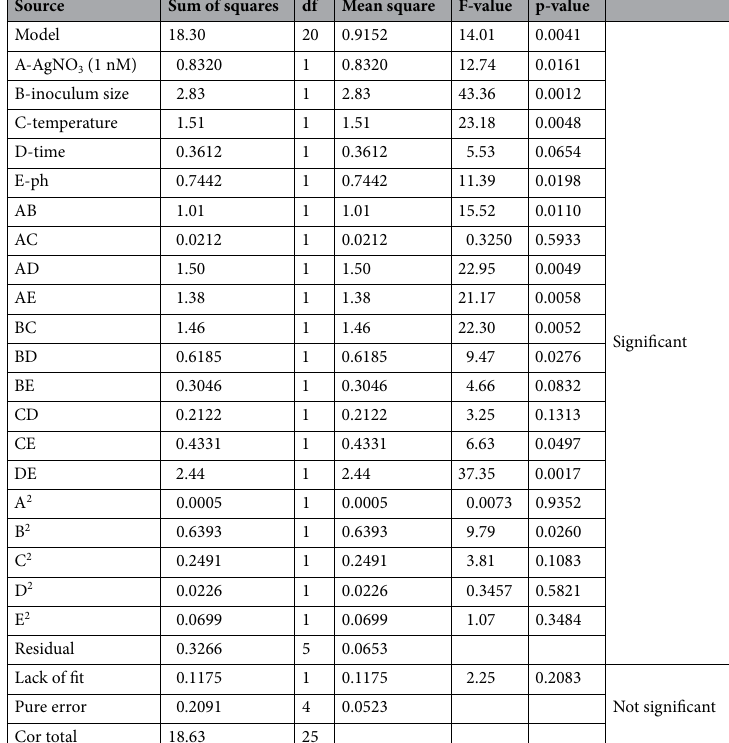
Table 3. ANOVA for quadradic model.